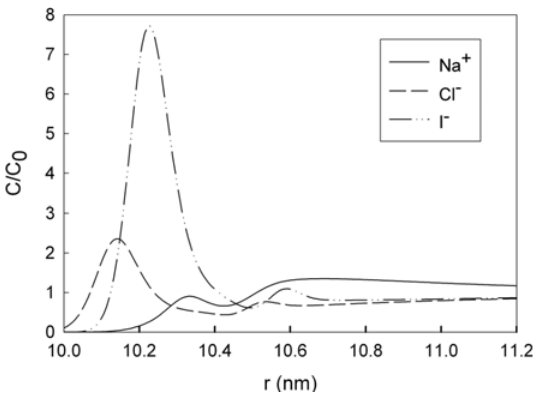
Fig. 9 – Concentration profile of anions and cations (mixed salt with equal concentrations of NaCl and NaI) outside of an uncharged hydrophobic colloidal particle with radius 10 nm at a total bulk concentration C 0 = 0 . 2